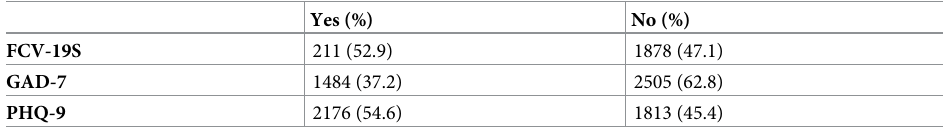
Table 4. Classification of participants according to FCV-19S, GAD-7, and PHQ-9 cutoff